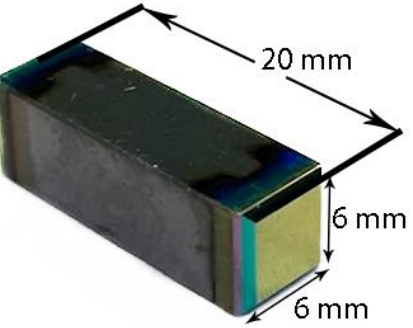
Figure 1. The photograph of ZGP OPO element with ZnSe/Al 2 O 3 AR